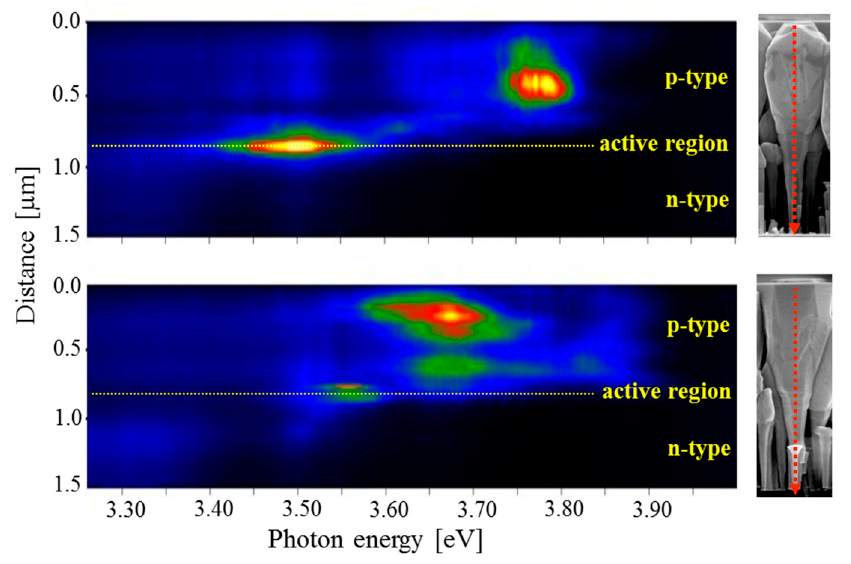
Figure 7. CL line-scans collected along the individual NWs: upper panel—scan along the oval-like NW; bottom panel—scan along the hexagonal one. The bright emission from the active region is observed in the Ga-face NWs. The N-face NWs had a strong emission related to the A4 peak at 3.65 eV, which was emitted in the upper part of the NW. The arrows on the SEM images indicate the direction of the scans.